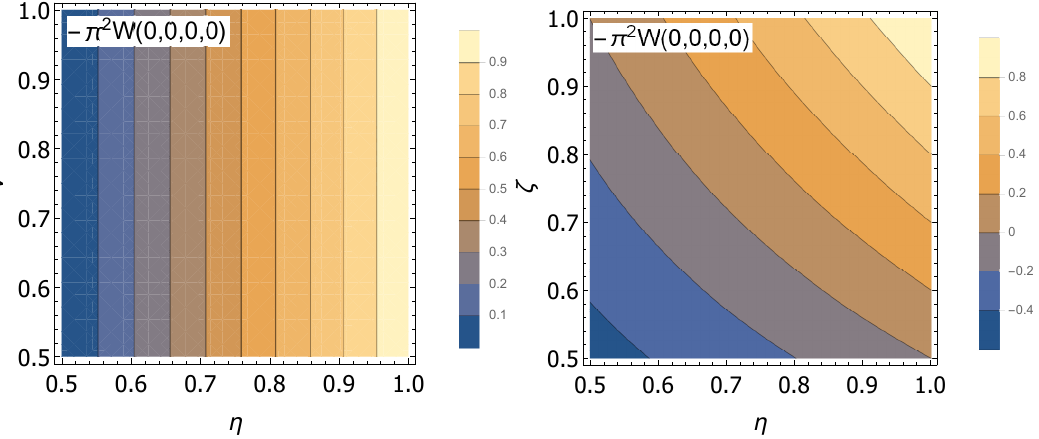
Figure 7. Plots of − π 2 W E (cid:48) ( 0,0,0,0 ) for different values of propagation and coupling losses in the main channels η , total efficiency of ancillary detectors ν and modal purity ζ . Left : − π 2 W E (cid:48) ( 0,0, 0,0 ) vs. ν - η with s = 0.2, t = 0.99 and ζ = 1. Right : − π 2 W E (cid:48) ( 0,0,0,0 ) vs. ζ - η with s = 0.2, t = 0.99 and ν =